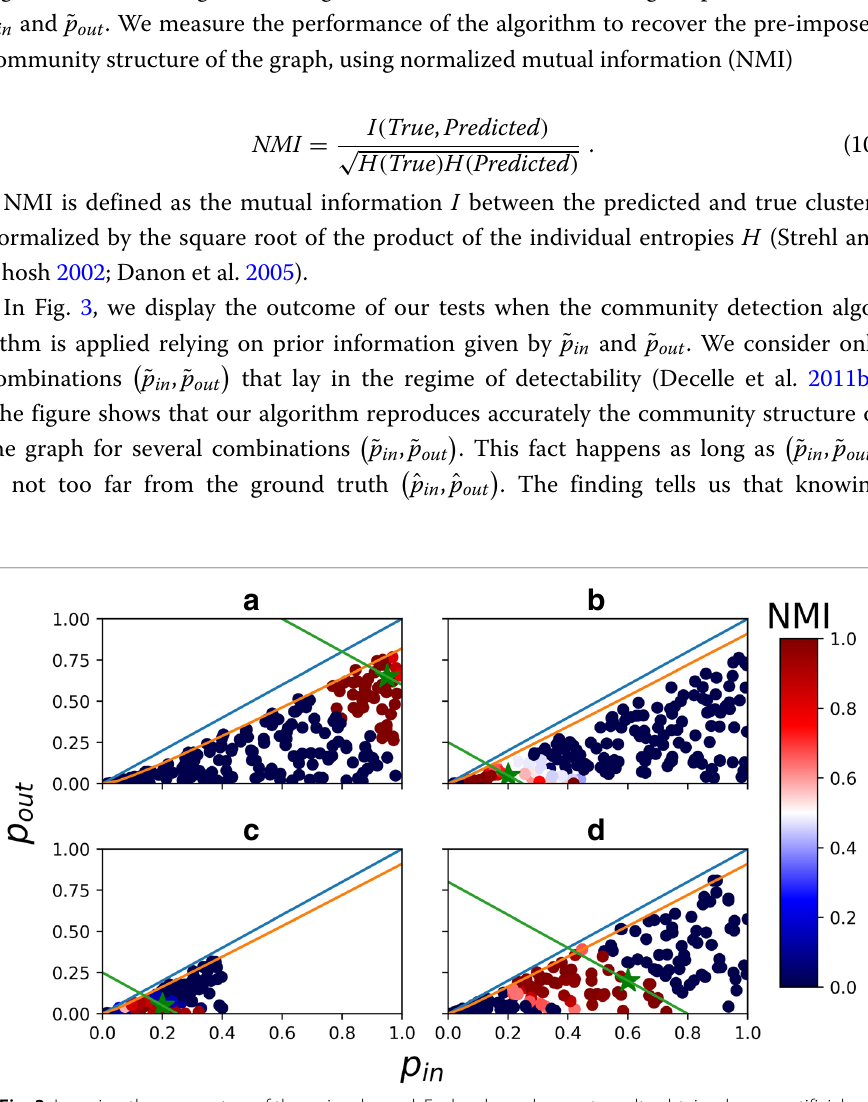
the model is set by fixing the sum of the true parameter values ˆ p in and ˆ p out , while the strength of the community structure is instead determined by their difference. We con-